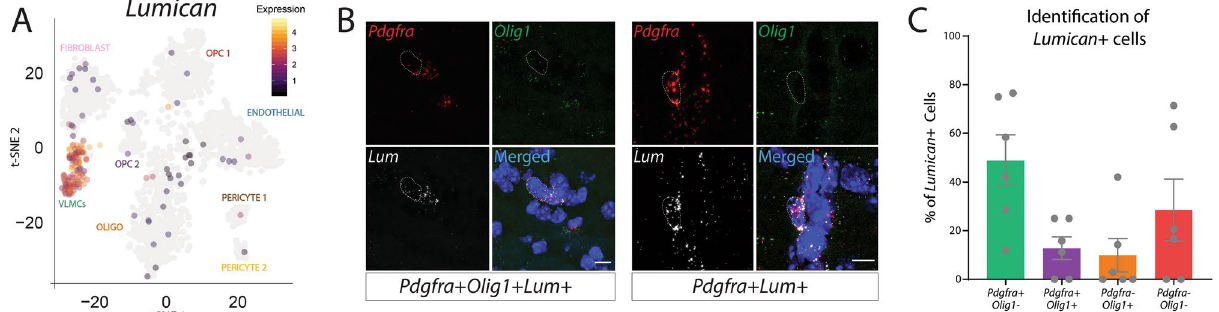
Figure 8. Lumican + fibroblast-like cells are found in the brain parenchyma. ( A ) Expression of Lumican , a marker of the VLMC cluster overlaid on the tSNE map. ( B ) Representative RNAscope images of an OPC ( Pdgfra + Olig1 +) and a fibroblast-like cell (Pdgfra + Olig1 −) expressing Lumican in the brain parenchyma. White dotted line indicates the nuclear outline. ( C ) Quantification of the percentage of Lumican + cells in each mouse that also expressed Pdgfra , Olig1 , both, or neither. N = 3 individual experiments, n = 6 biological samples (3 males and 3